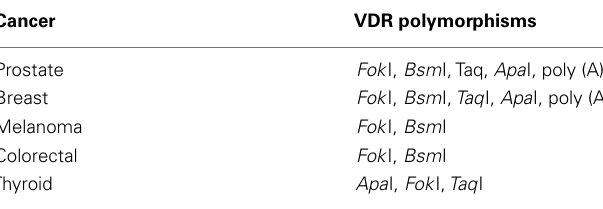
Table 1 |VDR polymorphisms associated with